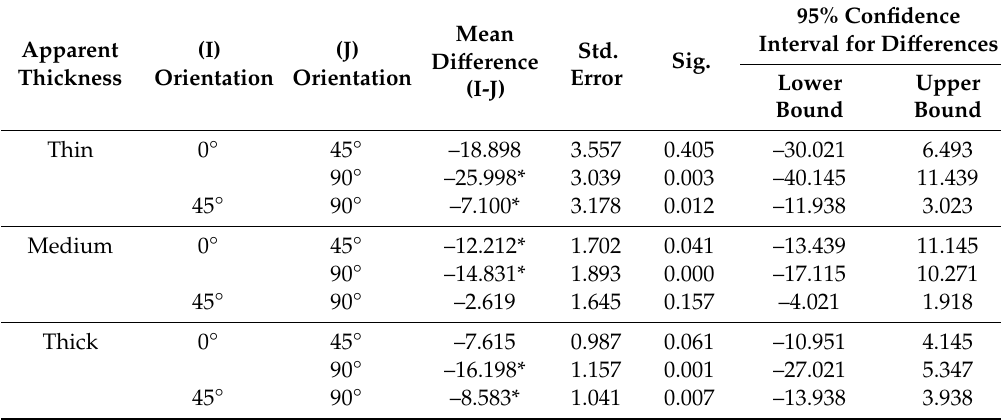
Table 3. Pairwise comparisons between lines with varying orientations and thicknesses. Significant di ff erences are indicated by an asterisk